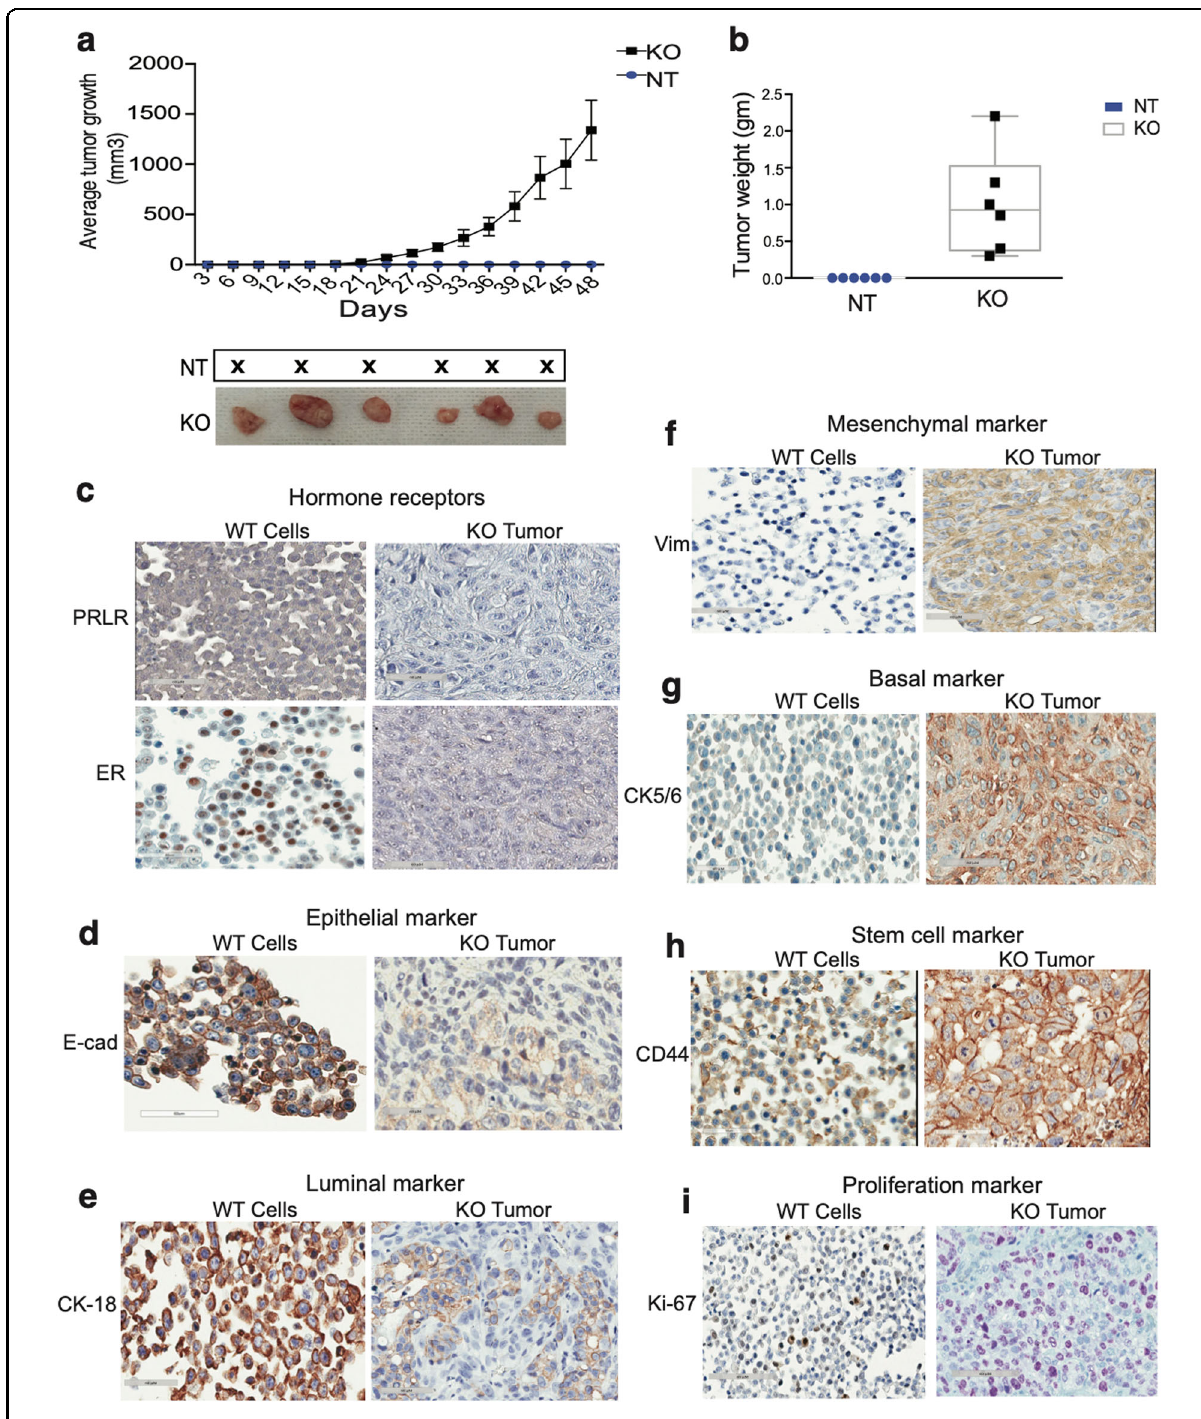
Fig. 5 Loss of PRLR expression in MCF-7 breast cancer cells generated mesenchymal and basal-like tumors in vivo. a Upper panels, tumor volume measurements of xenografts of MCF-7NT and MCF-7/PRLRKO followed for a period of 48 days, * P 0.012 (Student ’ s t -test). Lowe panel, images of MCF-7/PRLRKO tumor-xenografts. b Tumor weight measurements of xenografts of MCF-7/NT and MCF-7/PRLRKO, ** P 0.0052 (Student ’ s t -test). c Immunohistochemical staining of hormone receptors (PRLR and ER) in MCF-7/WT cells and MCF-7/PRLRKO tumors (×40). d Immunohistochemical staining of the epithelial marker E-cad in MCF-7/WT cells and MCF-7/PRLRKO tumors (×40). e Immunohistochemical staining of the luminal marker CK18 in MCF-7/WT cells and MCF-7/PRLRKO tumors (×40). f Immunohistochemical staining of the mesenchymal marker vimentin in MCF-7/WT cells and MCF-7/PRLRKO tumors (×40). g Immunohistochemical staining of the basal marker CK5/6 in MCF-7/WT cells and MCF-7/PRLRKO tumors (×40). h Immunohistochemical staining of the stem cell marker CD44 in MCF-7/WT cells and MCF-7/PRLRKO tumors (×40). i Immunohistochemical staining of the proliferative marker Ki67 in MCF-7/WT cells and MCF-7/PRLRKO tumors (×40).